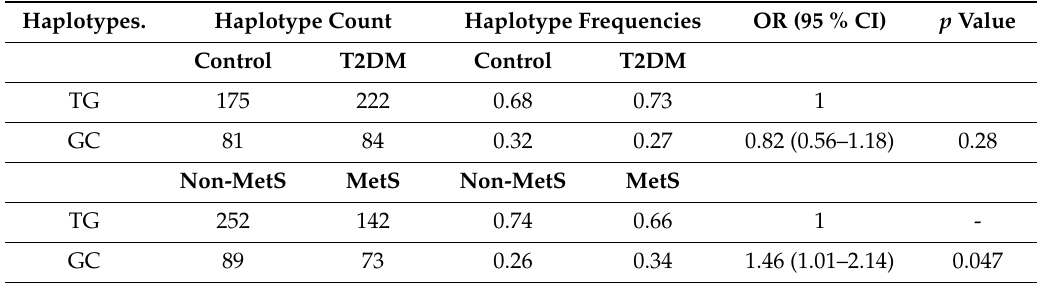
Table 6. Haplotype frequency of PLCXD3 variants (rs319013, rs9292806) in Control vs. T2DM and Non-MetS vs. MetS